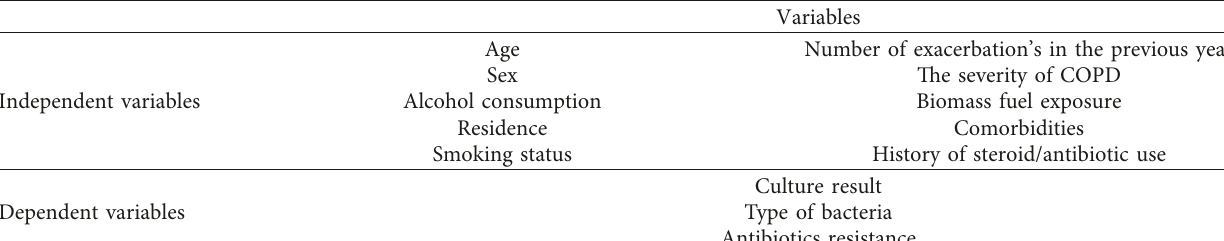
Table 1: List of study